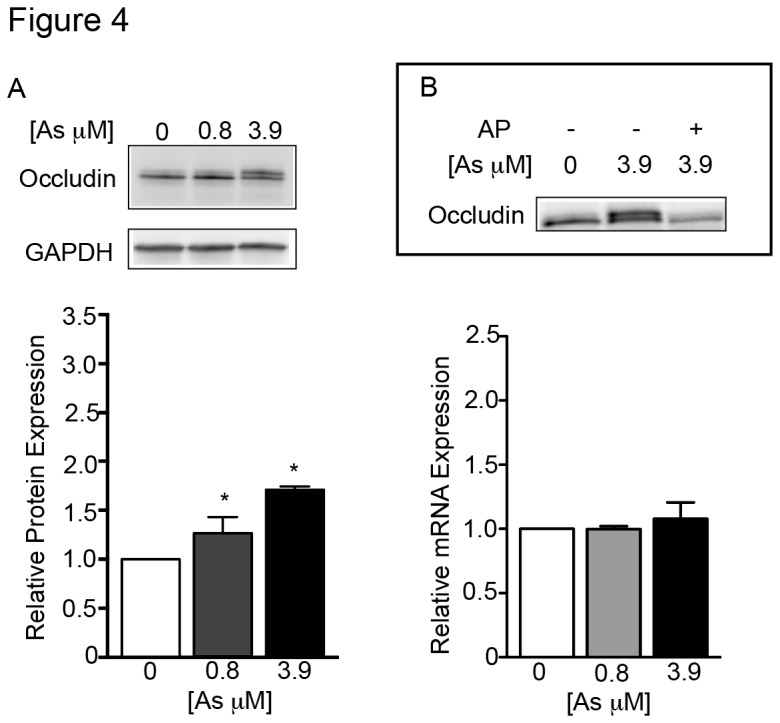
Arsenic exposure results in differential phosphorylation of occludin.Occludin protein levels were significantly increased following a 5-day arsenic exposure that was coincident with an increased phosphorylation state seen most prominently in the banding pattern of the 3.9 μM As-treated cultures. Occludin mRNA levels were not significantly altered by a 5-day arsenic exposure in 16HBE14o- cells. Representative Western blot and protein quantification (A - left) and mRNA quantification (A - right) of occludin under control and arsenic-treatment conditions (n = 3 for all experiments). Representative Western blot following alkaline phosphatase (AP) treatment of occludin (B).